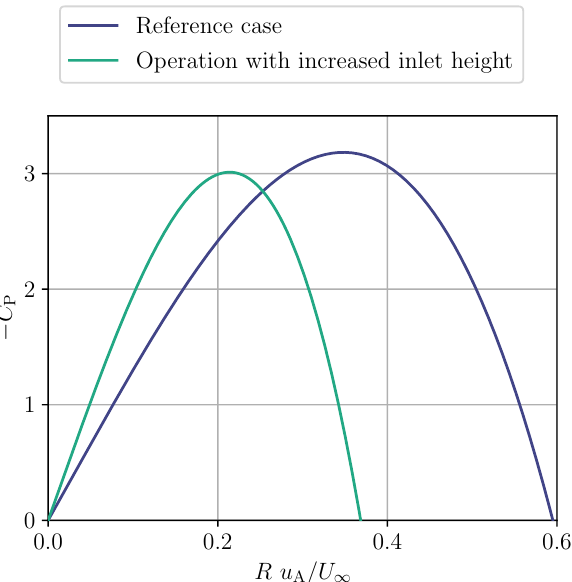
Figure 10. Power curves of the WVPP for two cases: the blue curve, already plotted in Figure 8, is for when h 1 = 0.825m; while the green curve is for the same installation when h 1 = 1.2m. Each curve is based on a single reading from a simplified CFD